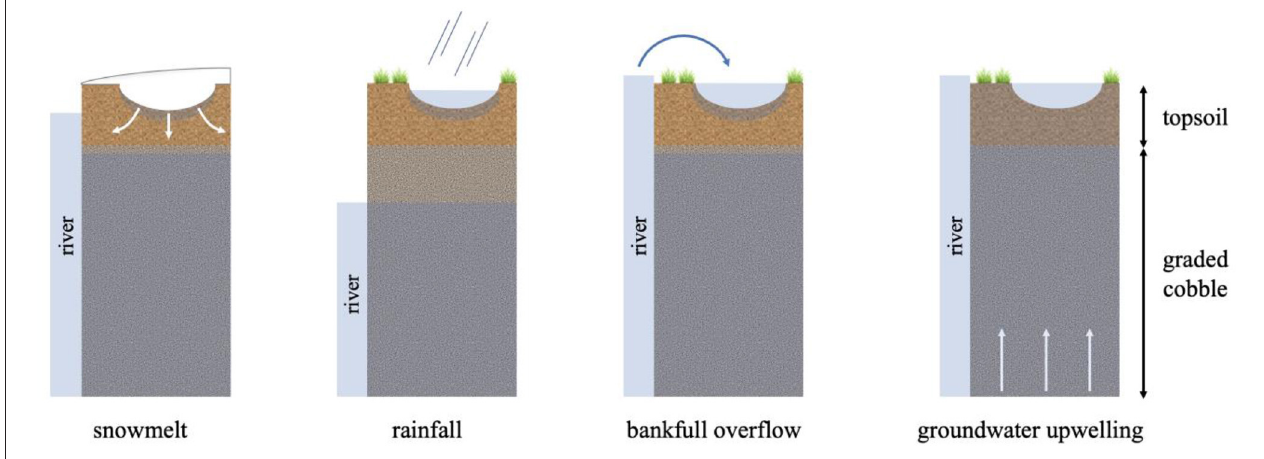
FIGURE 4 | Modes of surface flux modeled in simulations.